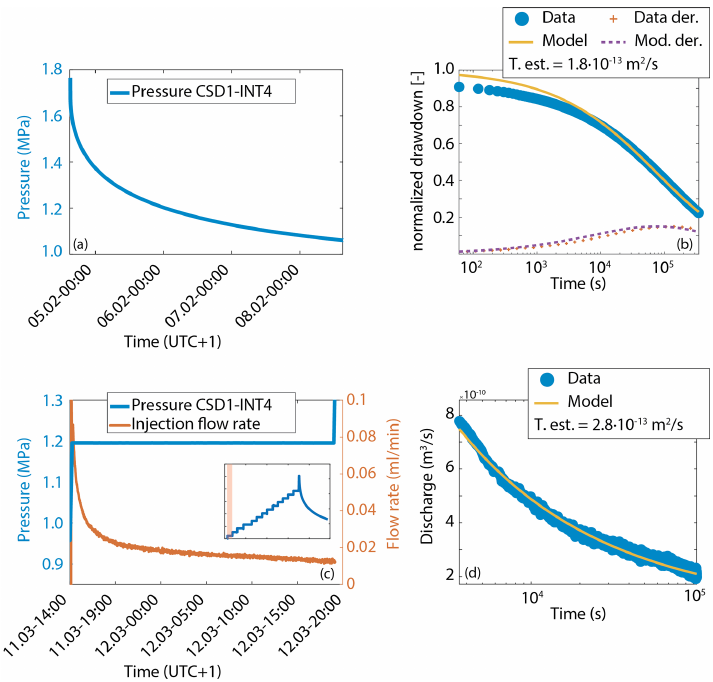
Figure 10. (a) Pressure decay after pulse in interval BCS-D1–Q4 (PST1). (b) Analytical model and model derivative for pressure decay (Renard, 2017) and estimated transmissivity. (c) First step of the test LST in interval BCS-D1–Q4 (red is the flow rate, blue the pressure at injection). (d) Analytical model of discharge (Renard, 2017) and estimated